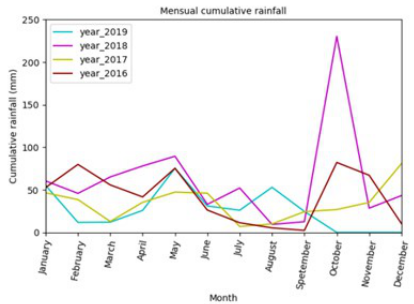
Figure 6. Monthly cumulative rainfall per year between 2016 and 2019 (in mm). Very high rainfalls in autumn 2018. The data are not available after October 2019.